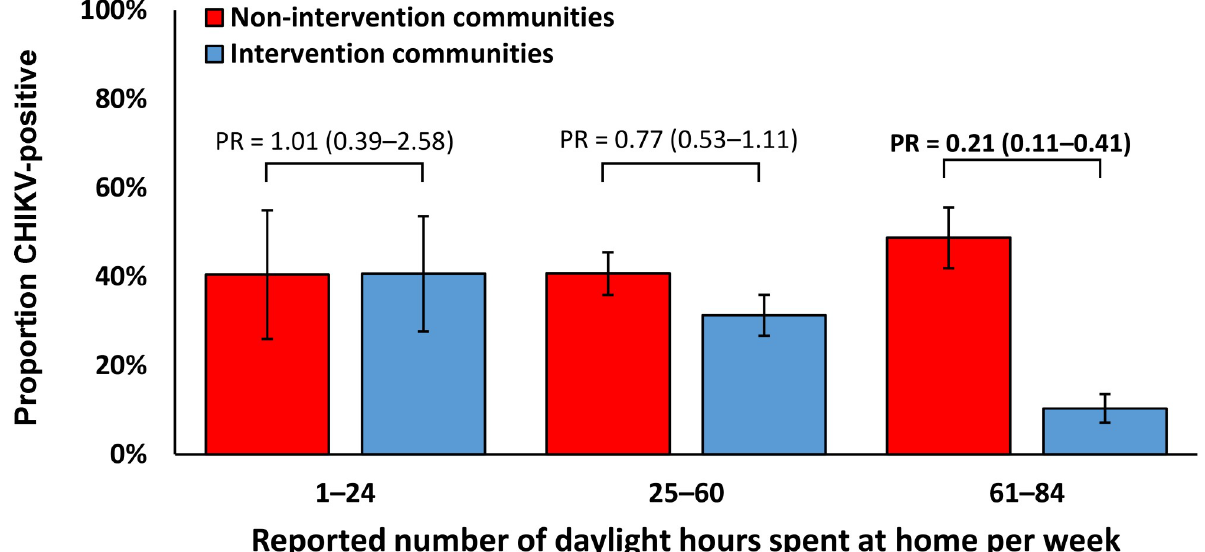
Fig 2. Estimated proportion of chikungunya virus infected residents of communities in Puerto Rico with (intervention; n = 175) or without (non-intervention; n = 152) autocidal gravid ovitraps (AGO traps) by reported number of daylight hours spent at home per week, November 2015–February 2016. Abbreviations: PR = prevalence ratio; error bars indicate standard